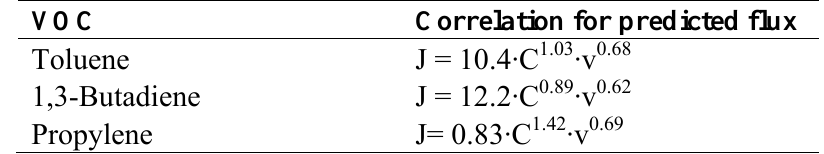
Table 1. Correlations of predicted flux obtained from experimental